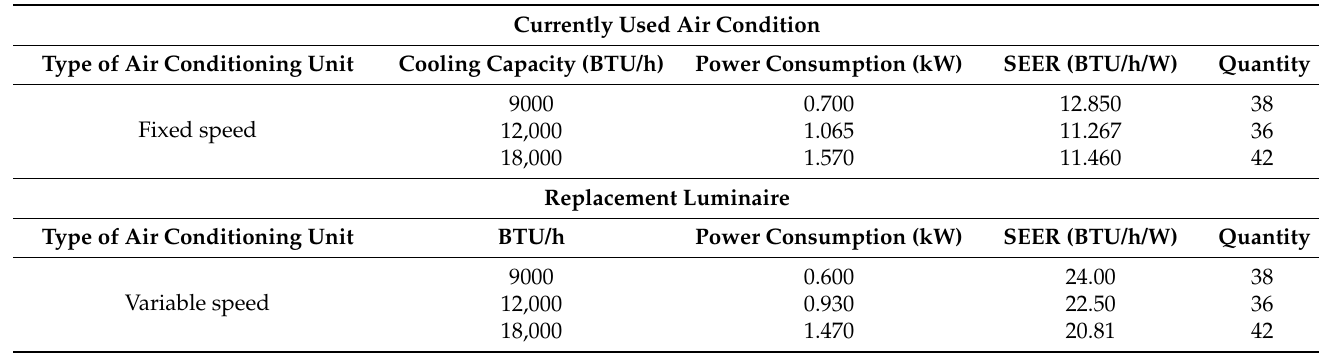
Table 11. Specifications of air conditioning employed in the case-study building. SEER: seasonal energy efficiency ratio. Currently Used Air Condition Type of Air Conditioning